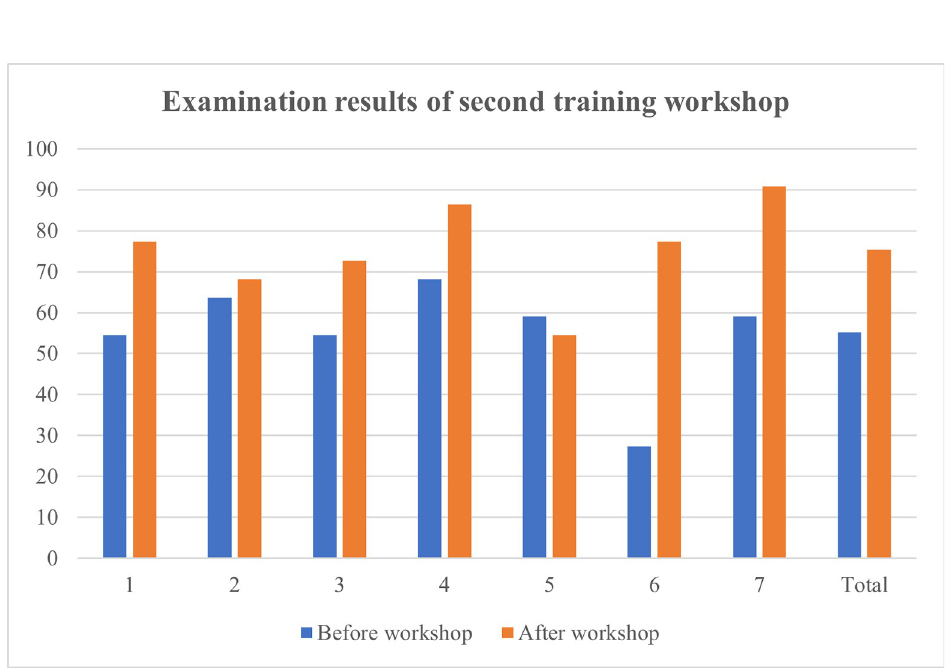
Fig 2. Comparison of participants’ knowledge assessment percentage results before and after the presentation of the second training workshop. 1 –participant 1; 2 –participant 2; 3 –participant 3; 4 –participant 4; 5 –participant 5; 6 –participant 6; 7 –participant 7.